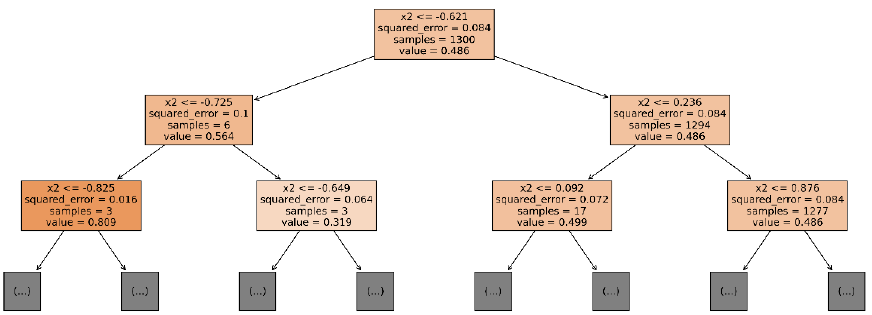
Figure 7. A subtree of the isolation forest when only the control flow constraint is